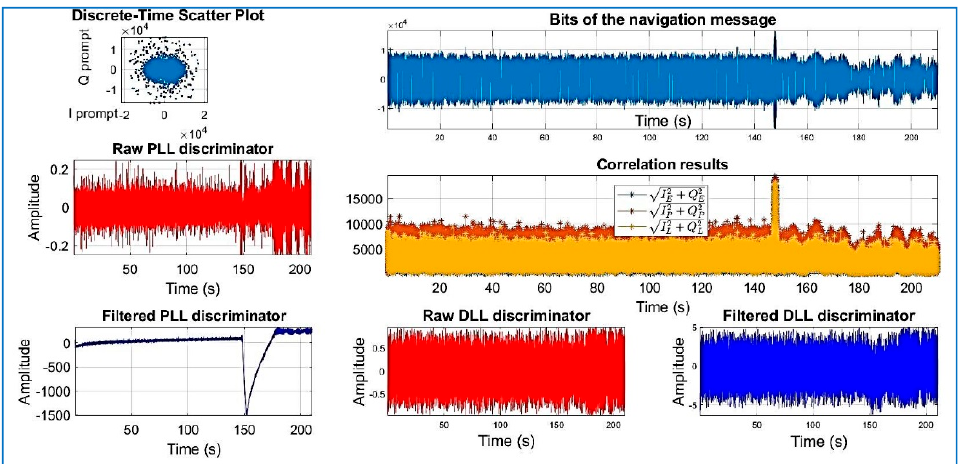
Figure 19. PRN 22, channel 02, Dataset 3. Sensors 2018 , 18 , x FOR PEER REVIEW 21 of 26